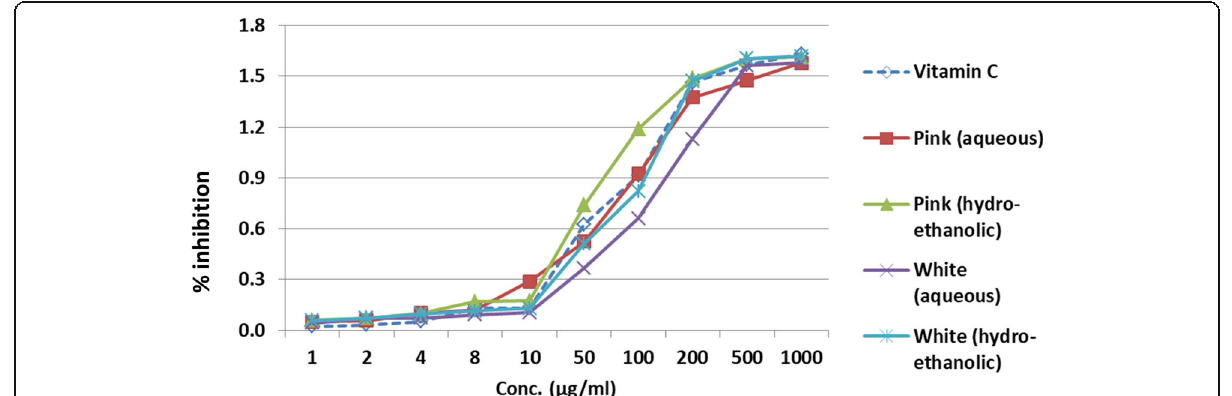
Fig. 3 DPPH assay depicting free radical scavenging activity of standard ascorbic acid and Guava extract